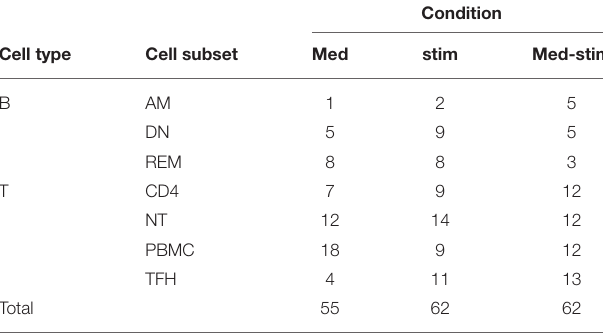
TABLE 1 | Study subjects’ characteristics. Baseline characteristics